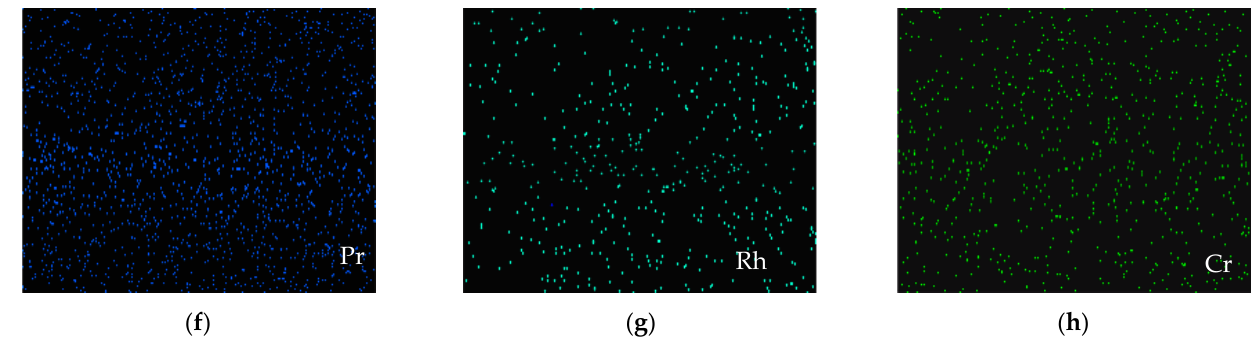
Figure 4. ( a ) SEM images, ( b ) EDX, and ( c – h ) elemental mapping images of RhCrO x /Pr-LaFeO 3 photocatalysts.